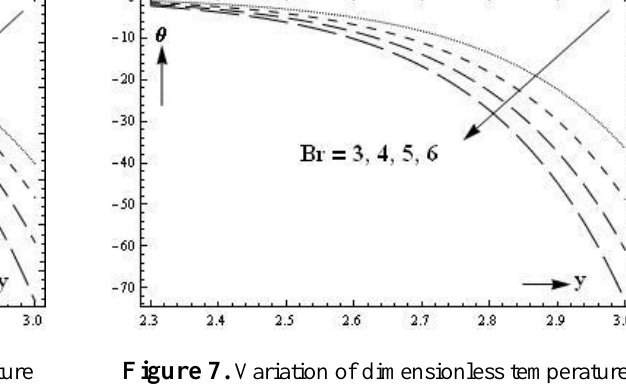
Figure 7. Variation of dimensionless temperature distribution for various values of Brinkman number.